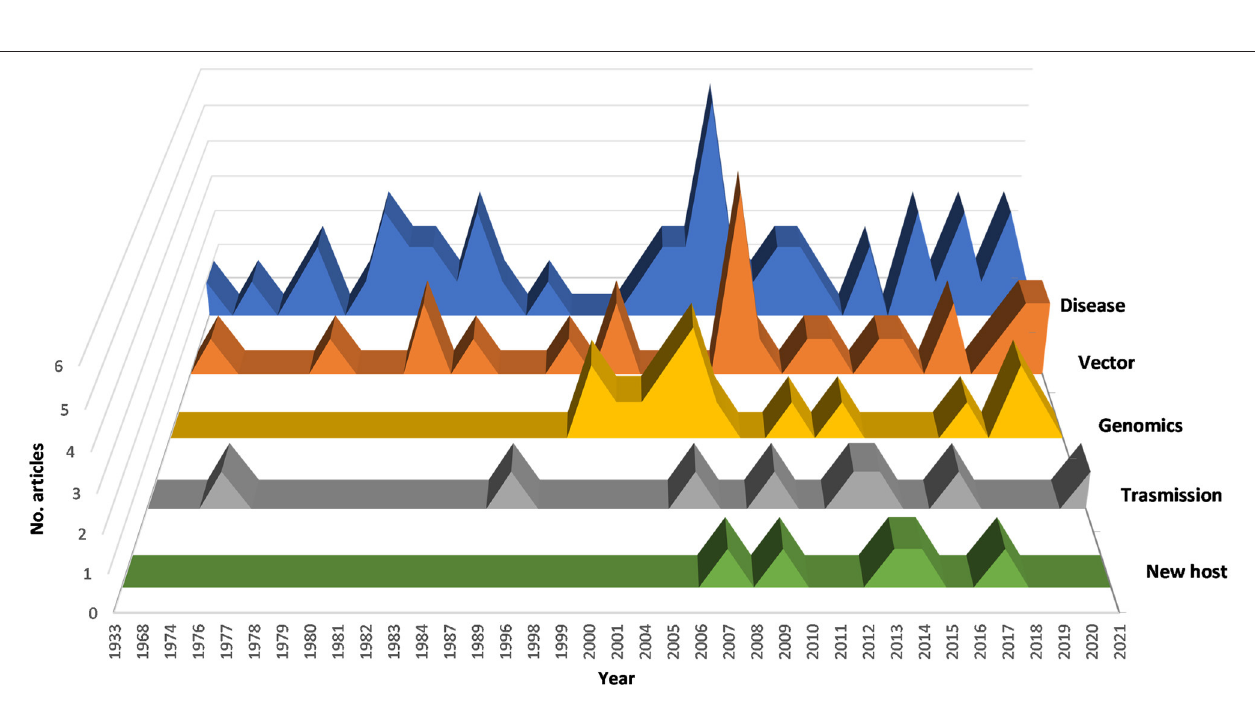
FIGURE 2 | Trend from 1974 to 2021 on the research topics